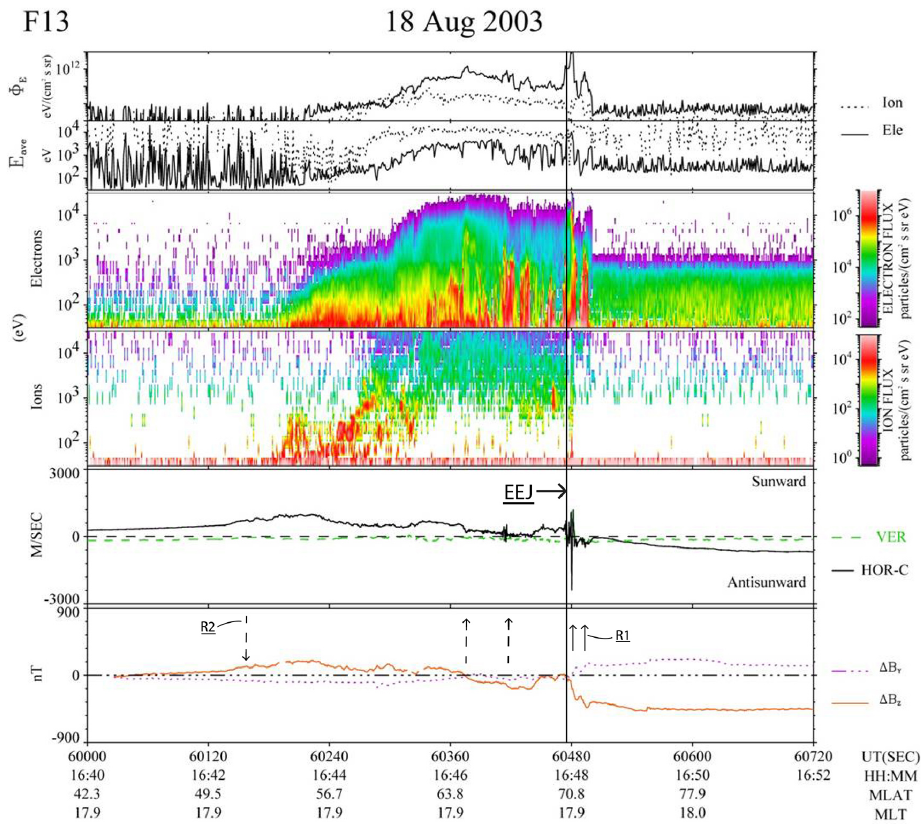
Fig. 7. DMSP F13 data for the dusk-side oval traversal from south to north during interval 16:40–16:52UT. Same format as in Fig. 6.